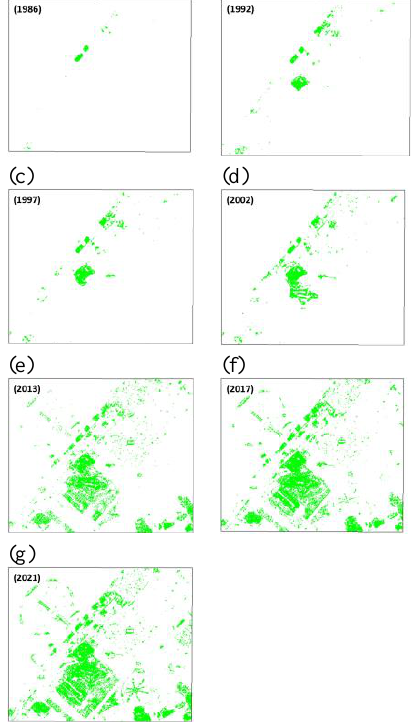
Figure 3 . Vegetation cover changes in Dubai during the study period (a) 1986, (b) 1992, (c) 1997, (d) 2002, (e) 2013, (f) 2017, and (g) 2021. For 1972 and 1978, there were no vegetation.